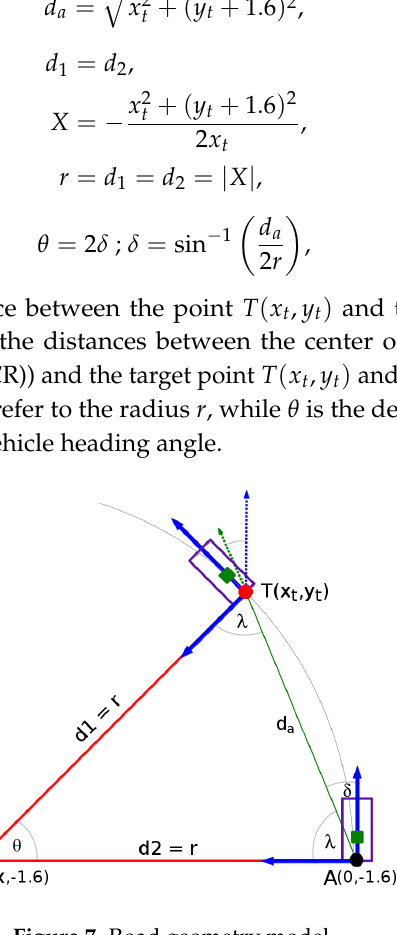
Figure 7. Road geometry